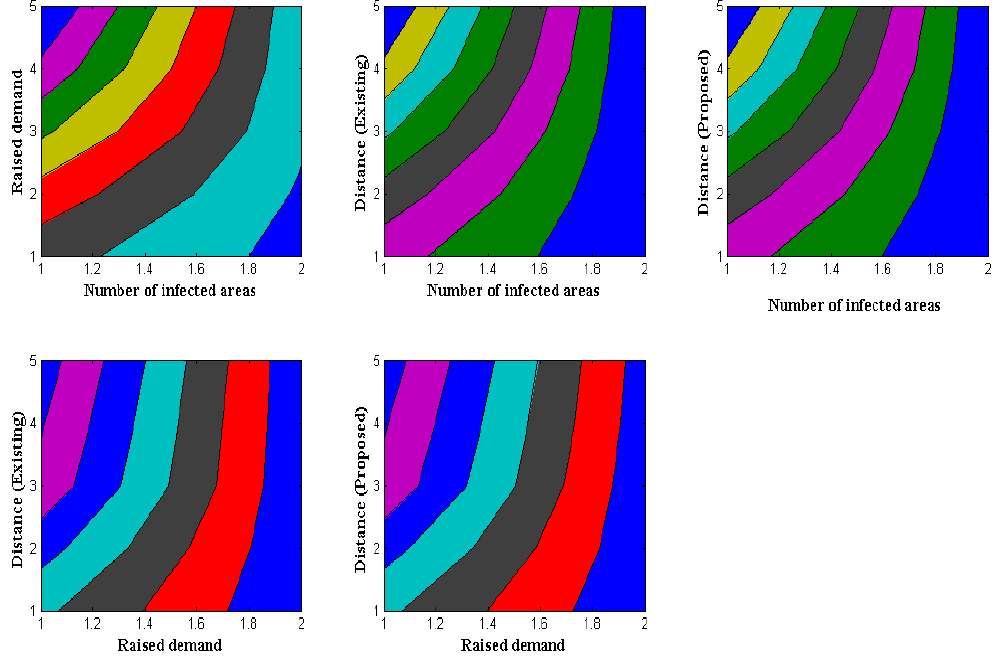
Figure 3. Distance and demand measurements. Table 4. Raised demand and distance.